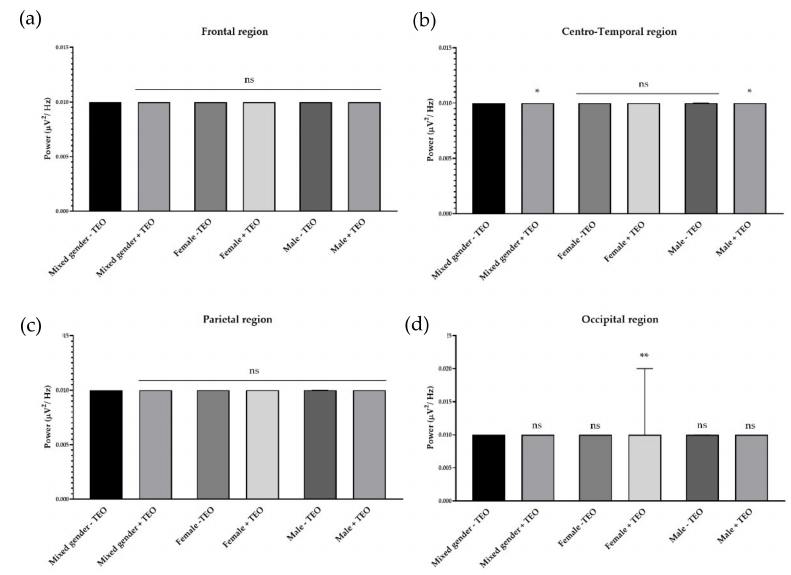
Figure 7. E ff ects of tangerine essential oil on high beta (25 Hz): ( a ) Frontal region; ( b ) Centro-Temporal region; ( c ) Parietal region; ( d ) Occipital region. p value: ns ≥ 0.05, * < 0.05, ** < 0.01.